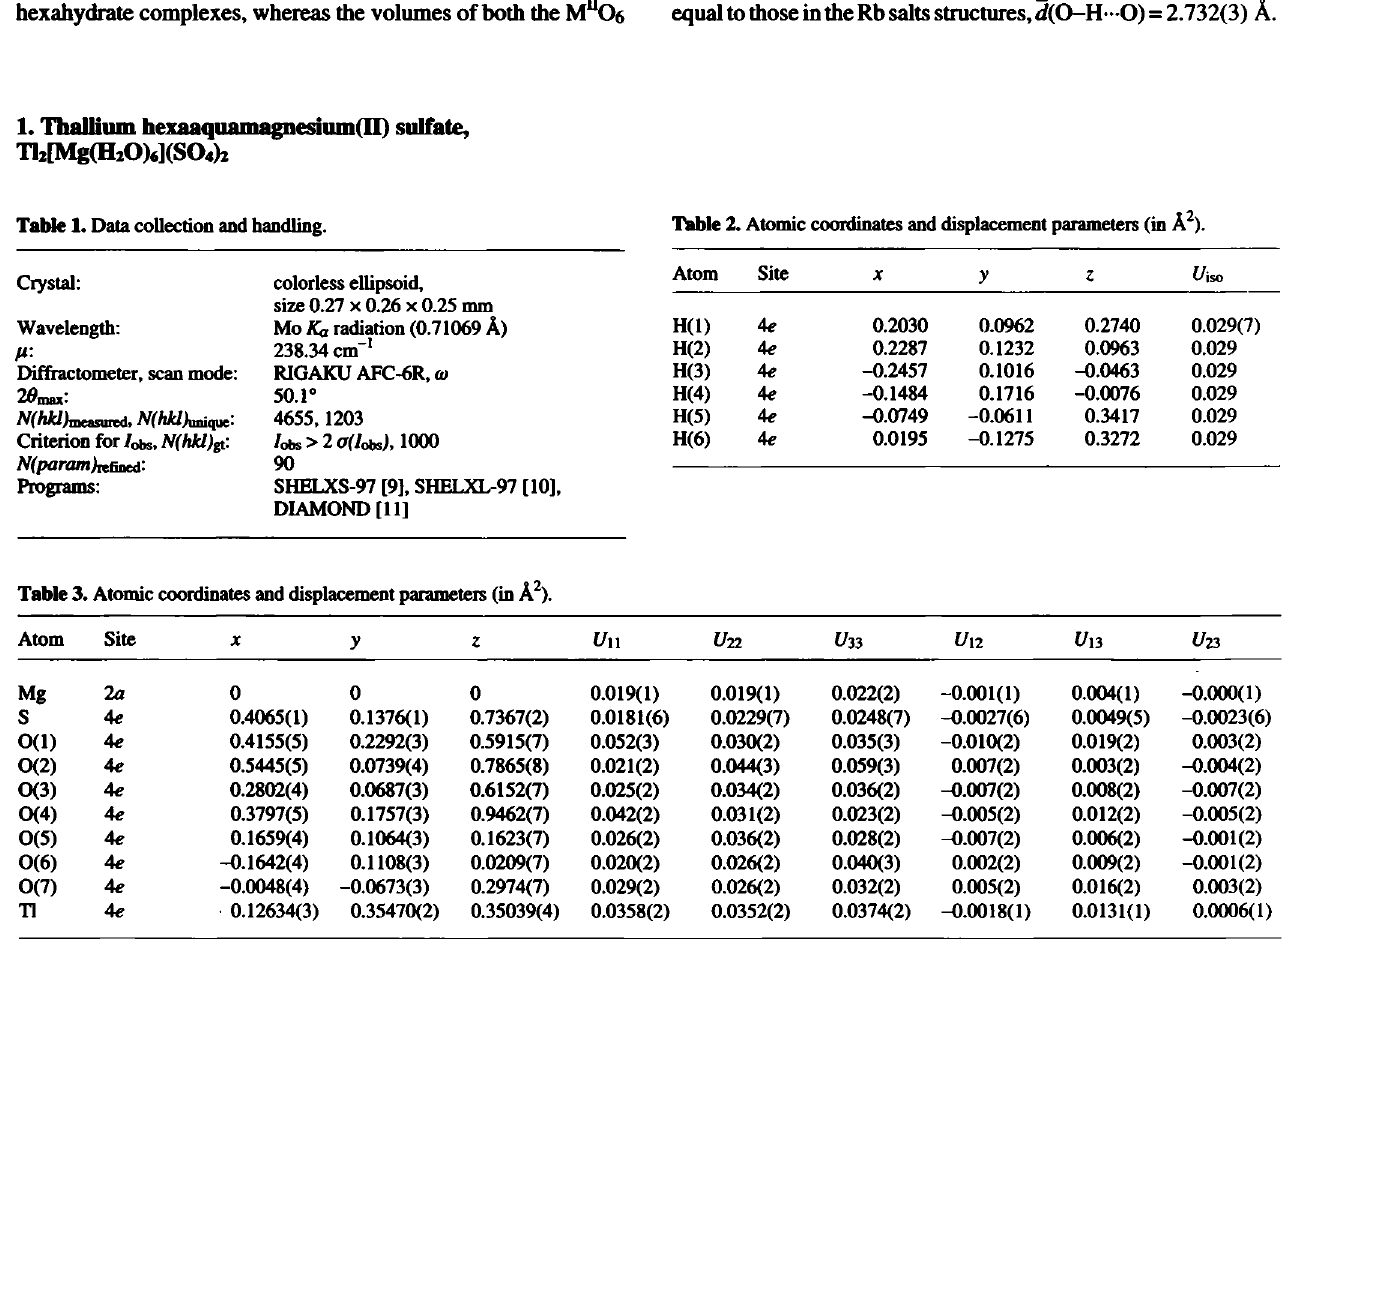
Table 3. Atomic coordinates and displacement parameters (in Â 2